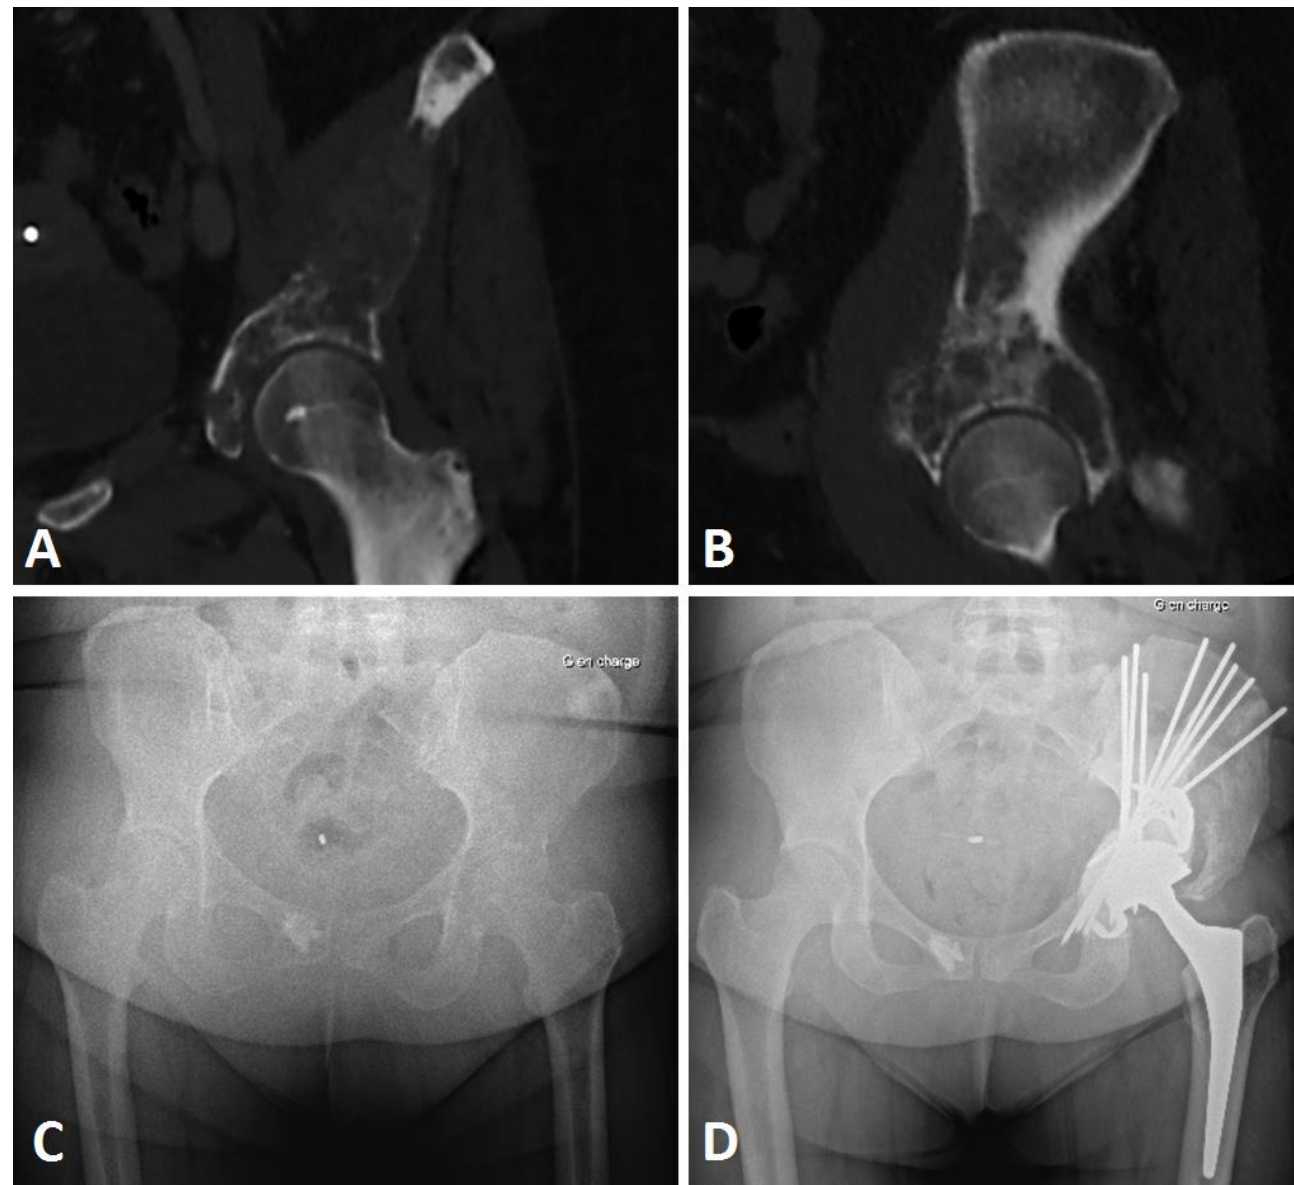
Figure 8. Imaging views of a breast metastatic iliac lesion Harrington class III. CT scan frontal ( A ) and sagittal views ( B ), preoperative AP X-ray ( C ), and postoperative ( D ) views of a Harrington procedure (Steinman pins and cement) associated with THA with acetabular reinforcement using a Kerboul cross-plate, in a metastatic localization of breast cancer with pelvic discontinuity at 2-year follow-up, Parker 9.